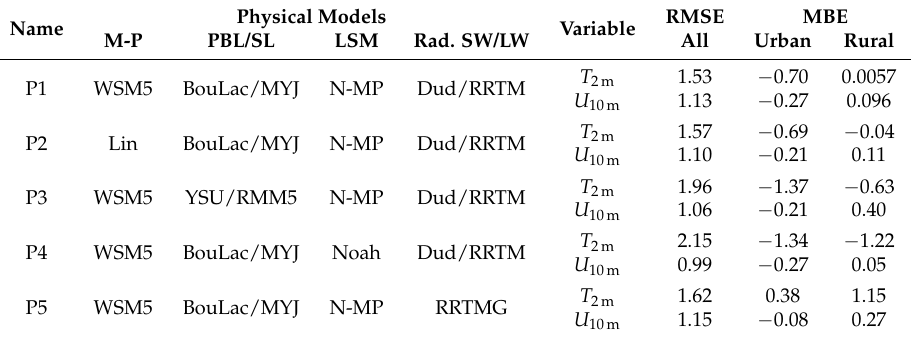
Table 10. Error metrics for temperature T 2m (in K) and wind speed U 10m (in m/s) comparing several combinations of physical models. The RMSE was calculated for all measurement stations; the MBE was calculated separately for urban and rural